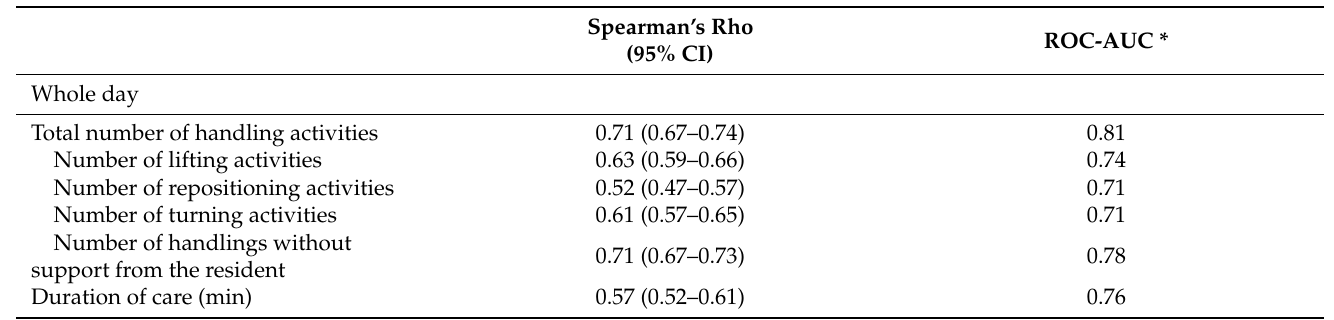
Table 2. Spearman’s rho correlation coefficient between the resident need-for-assistance scale and observed outcomes, and area under the receiver operating characteristics curve (ROC-AUC) values.